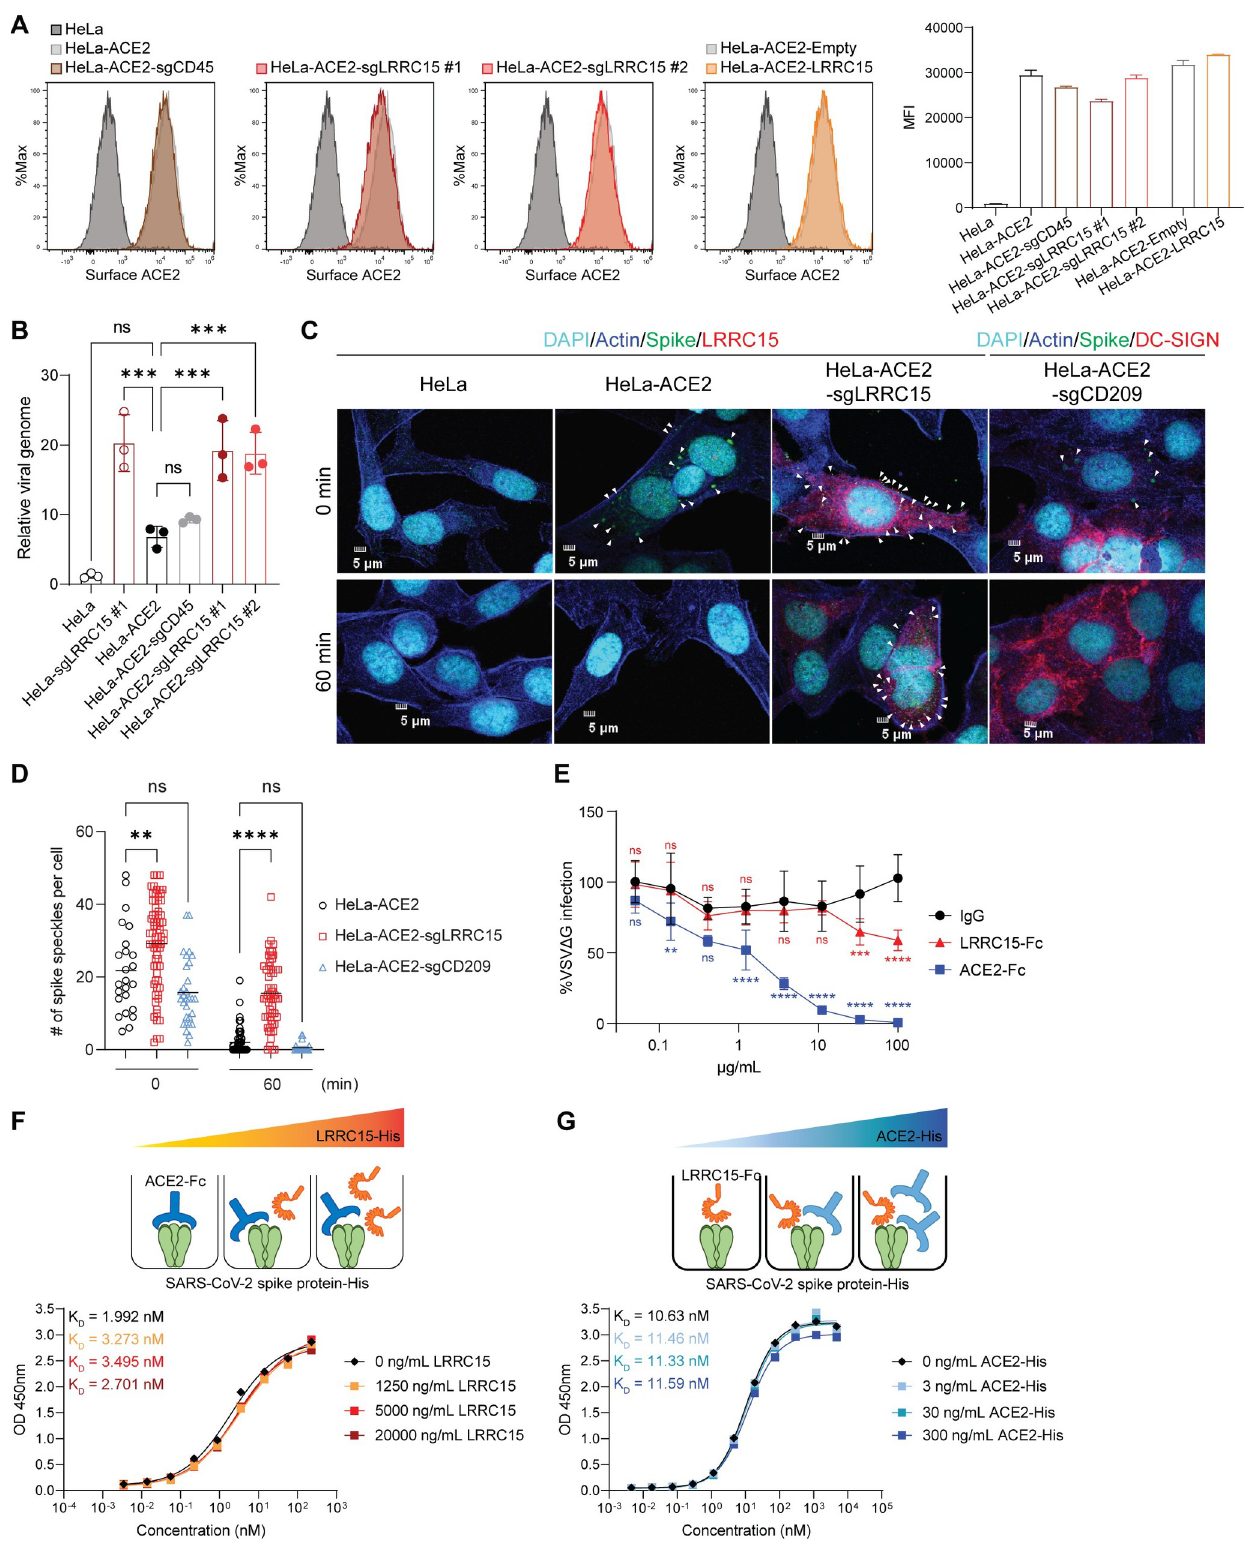
Fig 4. LRRC15 enhances SARS-CoV-2 attachment to the surface of ACE2-expressing cells. ( A ) HeLa-ACE2 cells were transduced with indicated activating sgRNAs or a LRRC15-expressing vector. Cell surface expression of ACE2 was measured by flow cytometry and calculated as MFI ( n = 3). ( B )